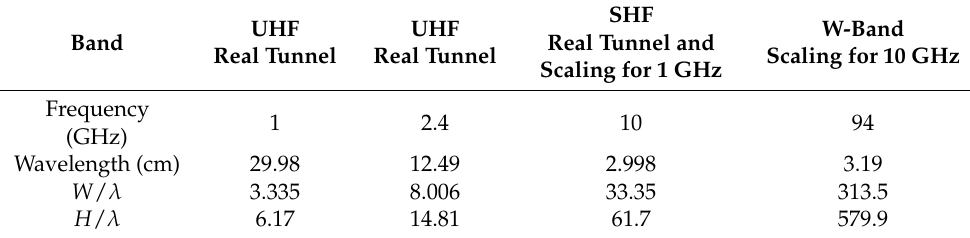
Table 1. Wave frequencies and respective scaling ratios.